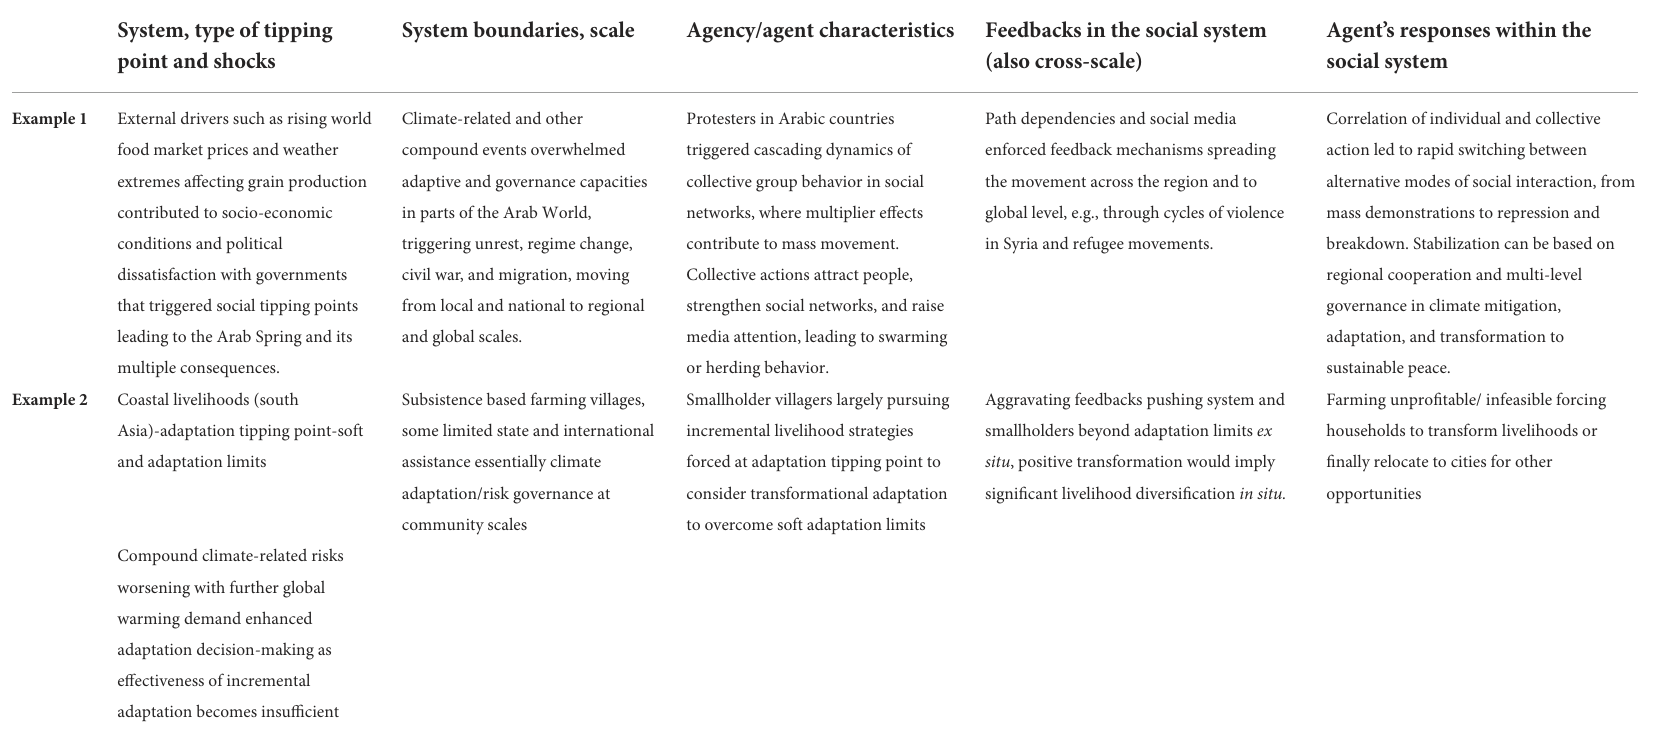
TABLE 1 Examples of tipping point